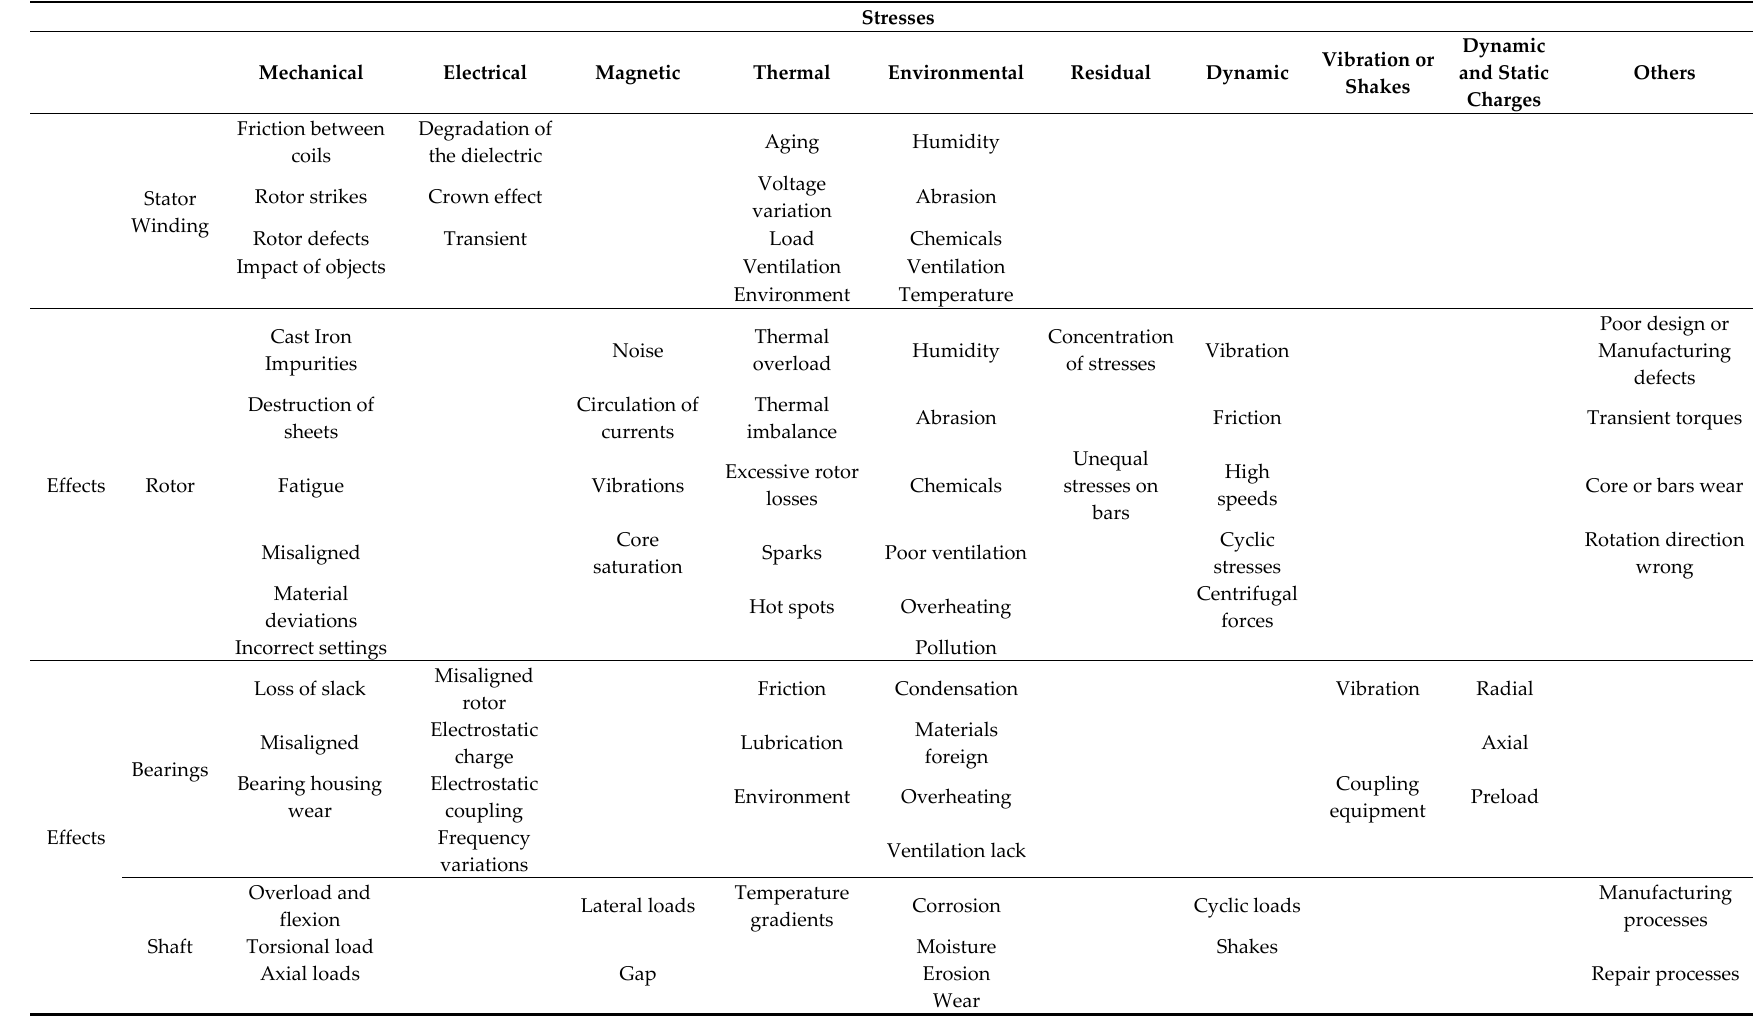
Table 3. Effects according to the type of efforts to which the parts of an induction motor are